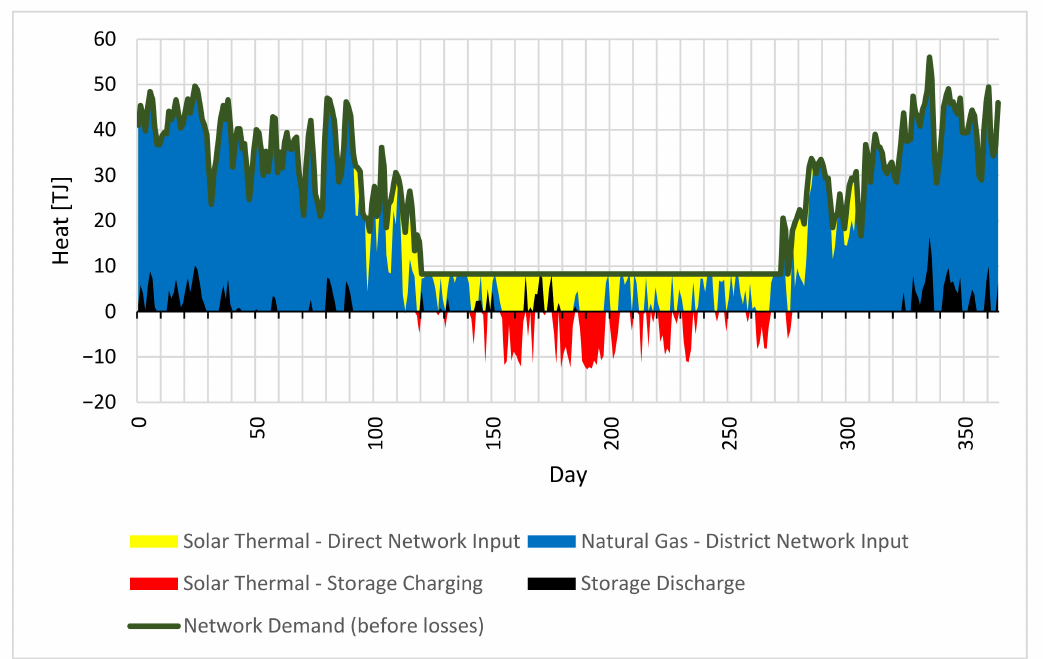
Figure 4. Daily heat flows in the system for the STAT scenario with the share of heat production from solar heating plants at least at the level of